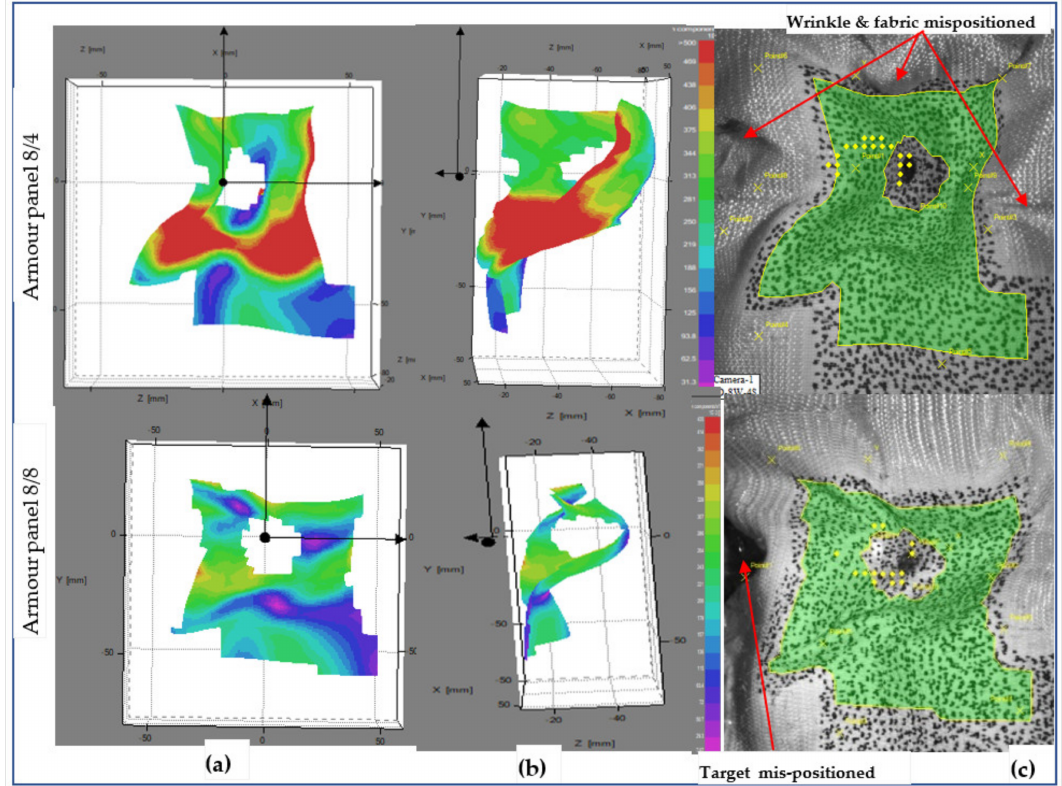
Figure 16. Surface displacement of frontal armour at impact times of 3.6 ms ( a , b ), 3D frontal and side views of stereoscopic images, respectively, and ( c ) frontal fabric panel images at shot point